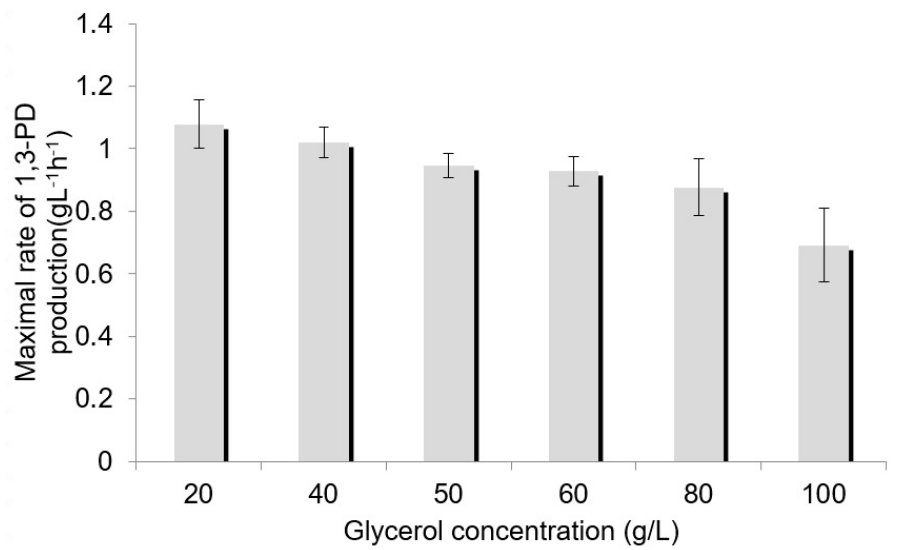
Figure 5. Effect of initial crude glycerol concentration on the maximum rate of 1,3-PD production.